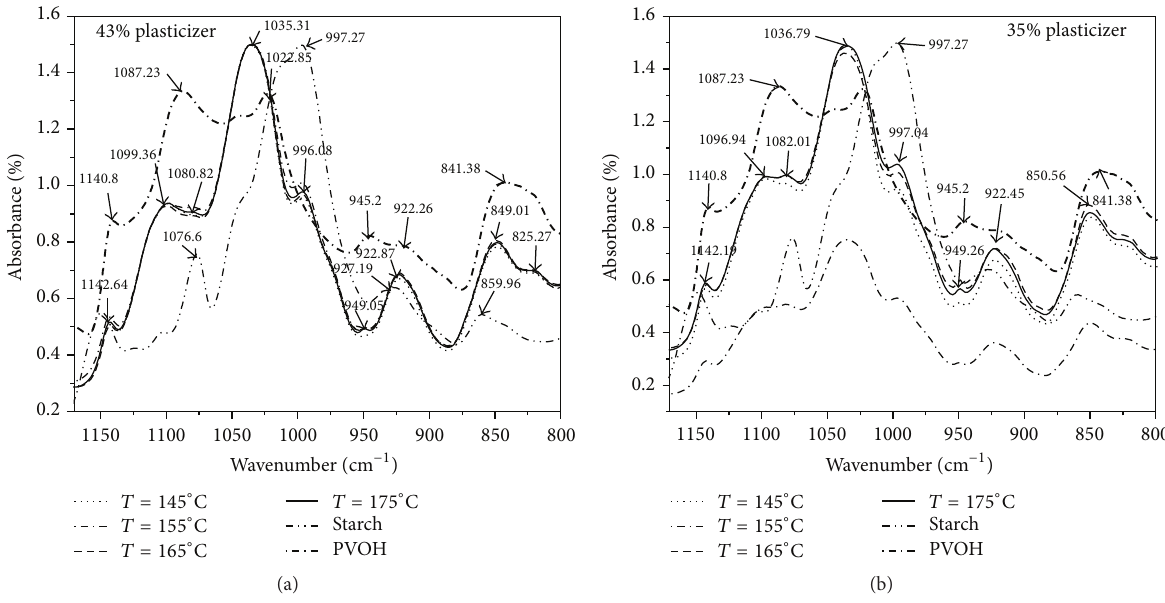
Figure 8: The dependence of the ATR absorption in the range of 1170cm −1 to 800 cm −1 on the plasticizing level ((a) 43%; (b) 35%) and the extrusion temperature (10kg